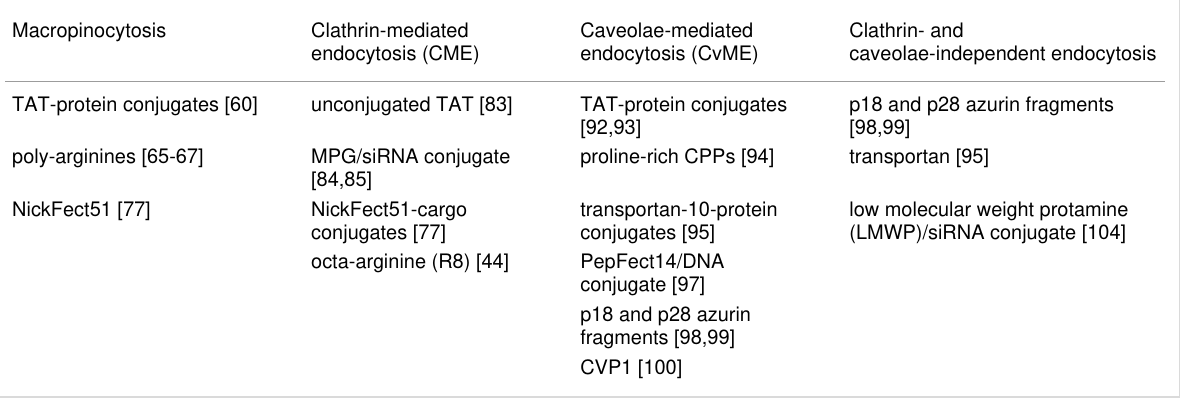
Table 2: Summary of the endocytic mechanisms used by CPP–cargo